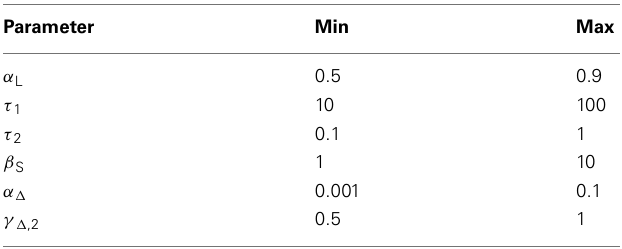
Table 1 |The ranges of the free model parameters, with a resolution of 100 values per